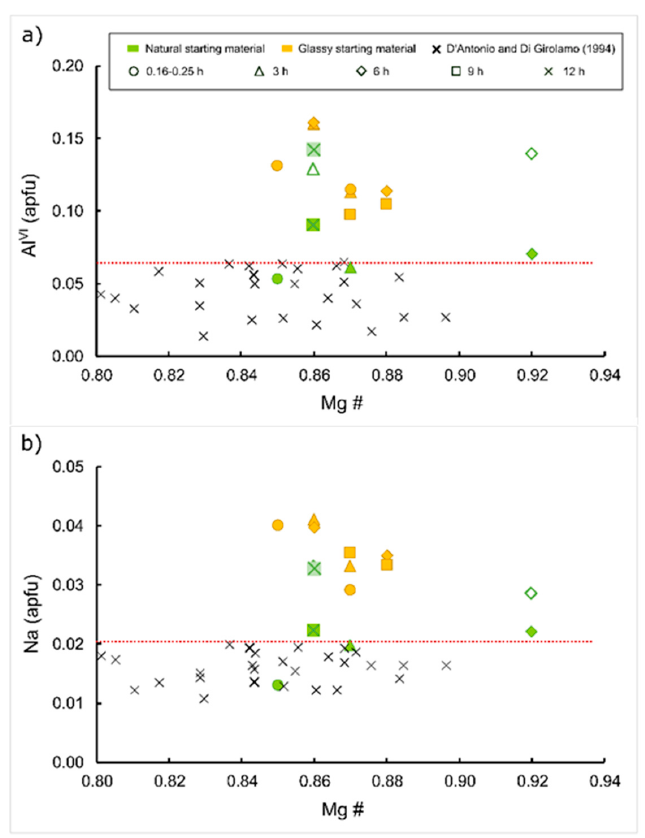
Figure 4. Al VI (apfu) vs Mg# ( a ) and Na (apfu) vs Mg# ( b ). Symbols are as in Figure 3. The red dotted line allows to discriminate between pre-existing nuclei and new forming crystals. This is an arbitrary limit drawn on the basis of the obtained results of this study and literature data from D’Antonio and Di Girolamo